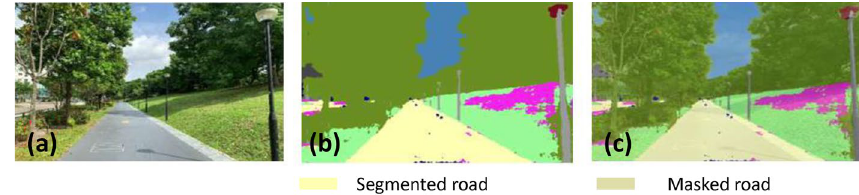
Figure 15. Offline results: road.